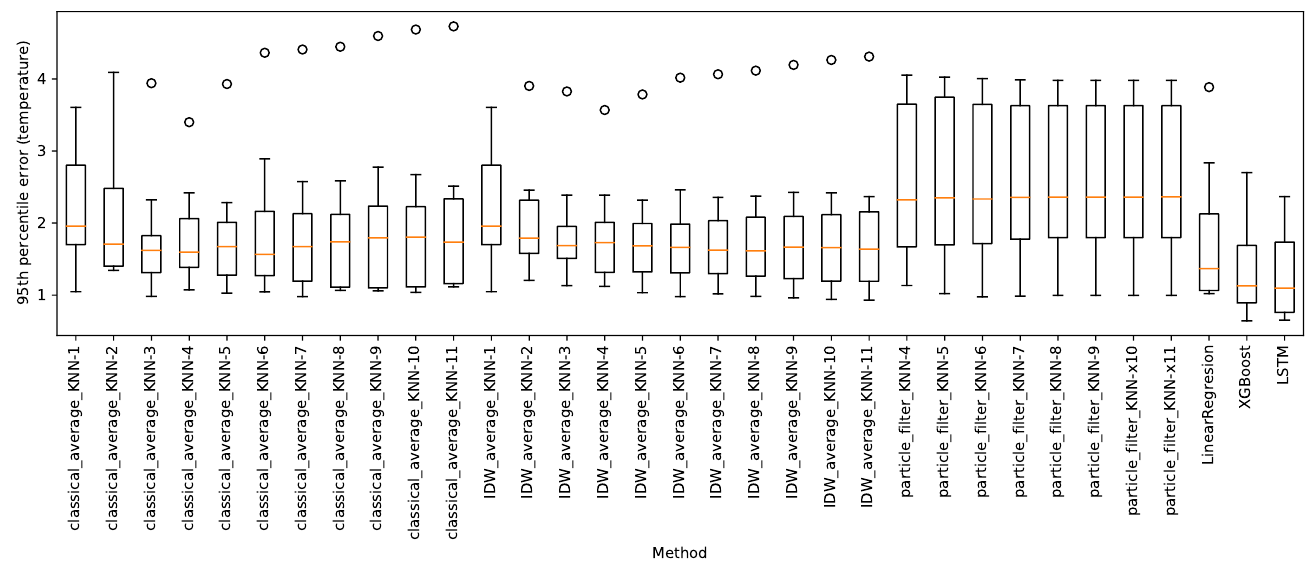
Figure 13. Boxplots of the 95th percentile of the error provided by the considered approaches.